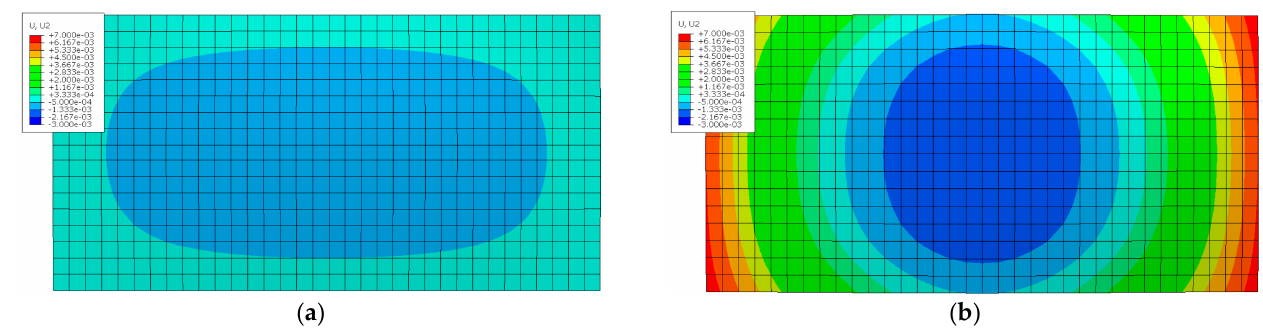
Figure 5. Out-of-plane displacements (‘summer’ load case) for: ( a ) flat IGU; ( b ) curved IGU. Note: Bottom view; values in m; the same scale was used for the legend on both figures (max: 7.0 mm, min: − 3.0 mm).